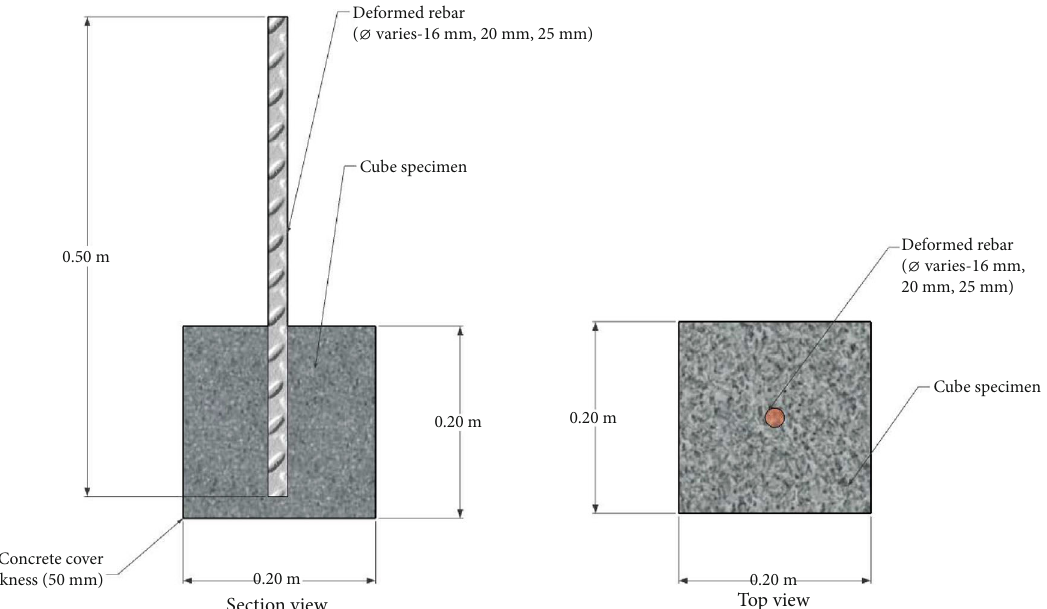
Figure 4: Detail of specimen with uncon fi nement.